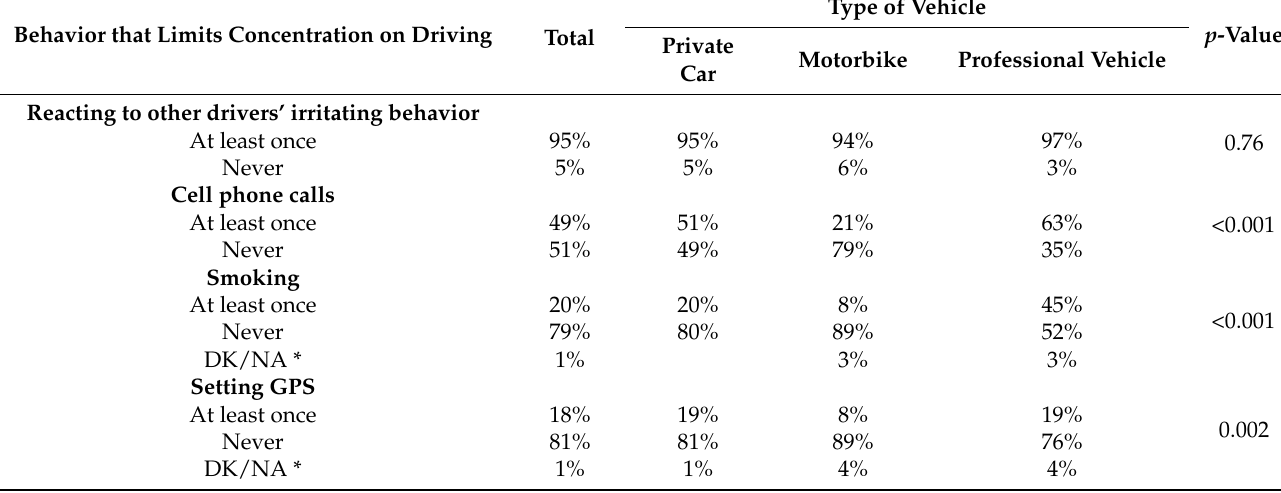
Table 4. Behavior that limits concentration in the total sample and by type of vehicle (questions were structured as “How many times in the past 3 months have you . . .